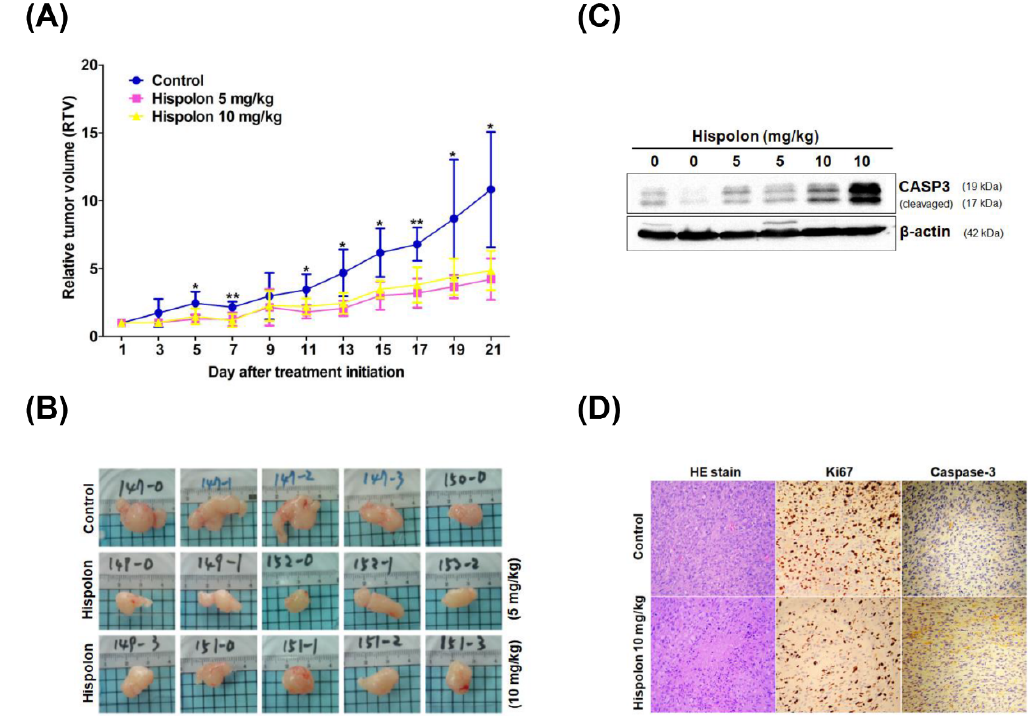
Figure 4. Hispolon inhibits tumor growth on DBTRG xenograft mice model. ( A ) NOD-SCID mice were injected with 1 × 10 6 DBTRG cells into the right dorsal subcutaneous tissue. Subcutaneous injections of hispolon ( ■ , 5 mg/kg; ▲ , 10 mg/kg) were initiated when the tumor reached an average size of 150 mm 3 . The relative tumor volumes were evaluated through analysis of variance with the Games–Howell test used as a post hoc test. * p < 0.05 versus vehicle and ** p < 0.01 versus vehicle. ( B ) Tumors in the control and hispolon-treatment groups were removed and recorded on day 21. ( C ) Hispolon induced the expression of cleaved caspase-3 in tumor tissues compared with control groups, as seen in western blot analysis. ( D ) Tumor tissue sections with HE, ki-67, and caspase-3 immunohistochemical staining. The ki-67- and caspase-3-positive cells were stained brown. The expression of ki-67 in tumor tissue was downregulated and the expression of caspase-3 was upregulated after hispolon administration compared with that in the control